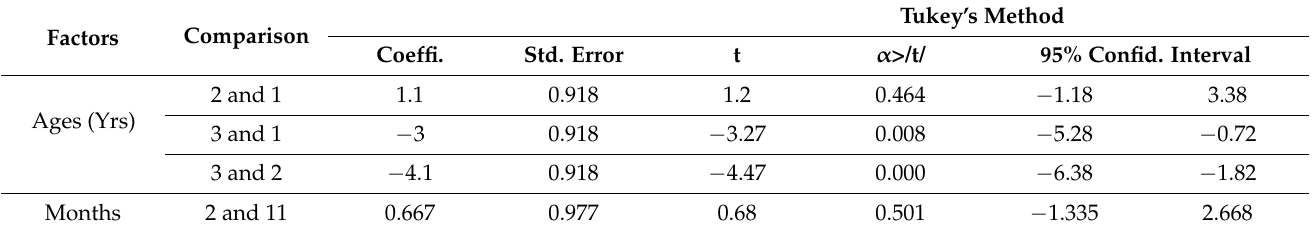
Table 6. Pairwise comparisons of the mean of Young’s moduli for the Mekaneselam